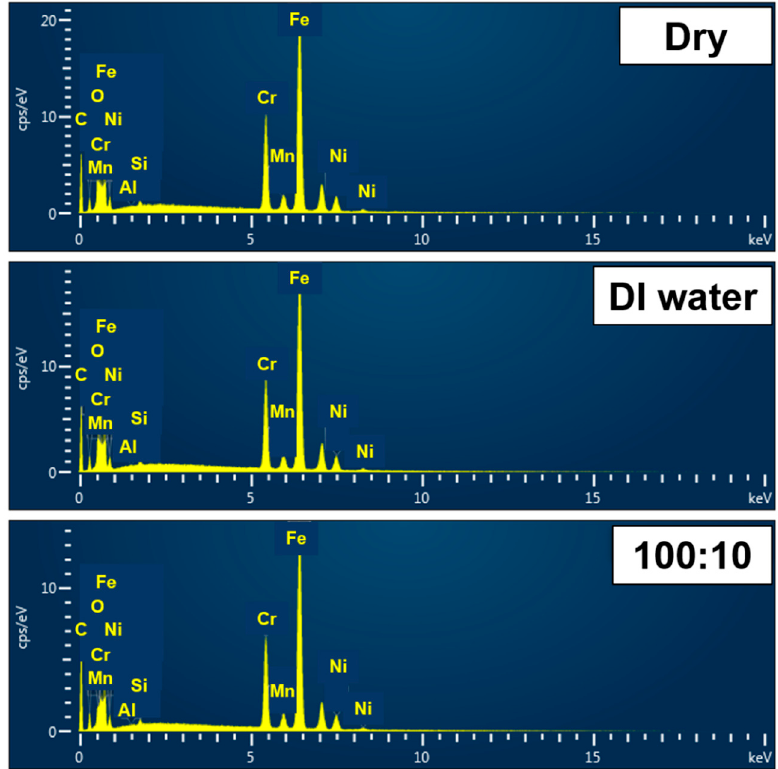
Figure 7. Results of EDS analysis on wear track surface after tribo-test during 100,000 cycles.